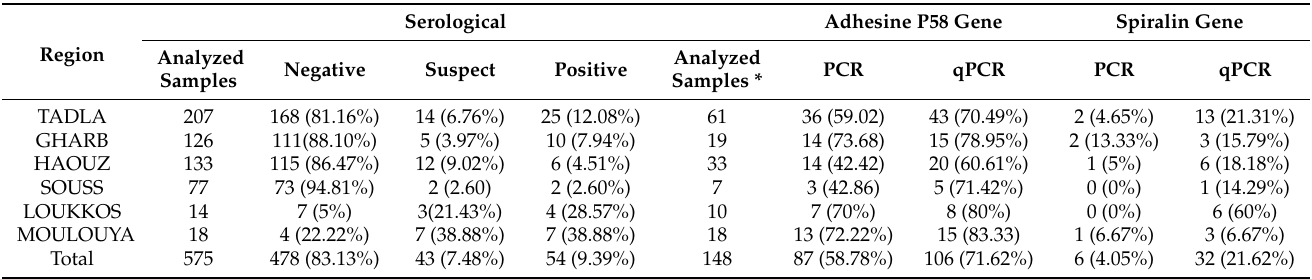
Table 1. DAS-ELISA and PCR test results of leaf samples collected across several citrus-growing areas in Morocco from July 2020 to October